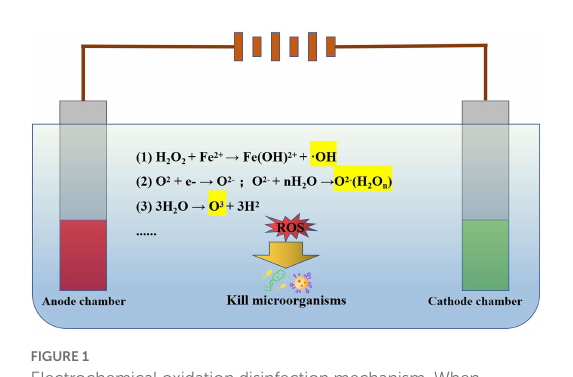
FIGURE 1 Electrochemical oxidation disinfection mechanism. When electrolyzing water, the redox reaction on the electrode surface can produce hydroxyl radicals, ozone, negative oxygen ions, etc., which can inactivate microorganisms in water by destroying their cell